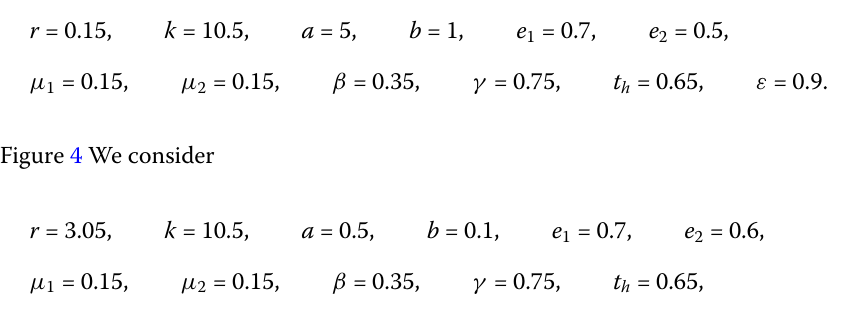
Figure 3 We set the following values of